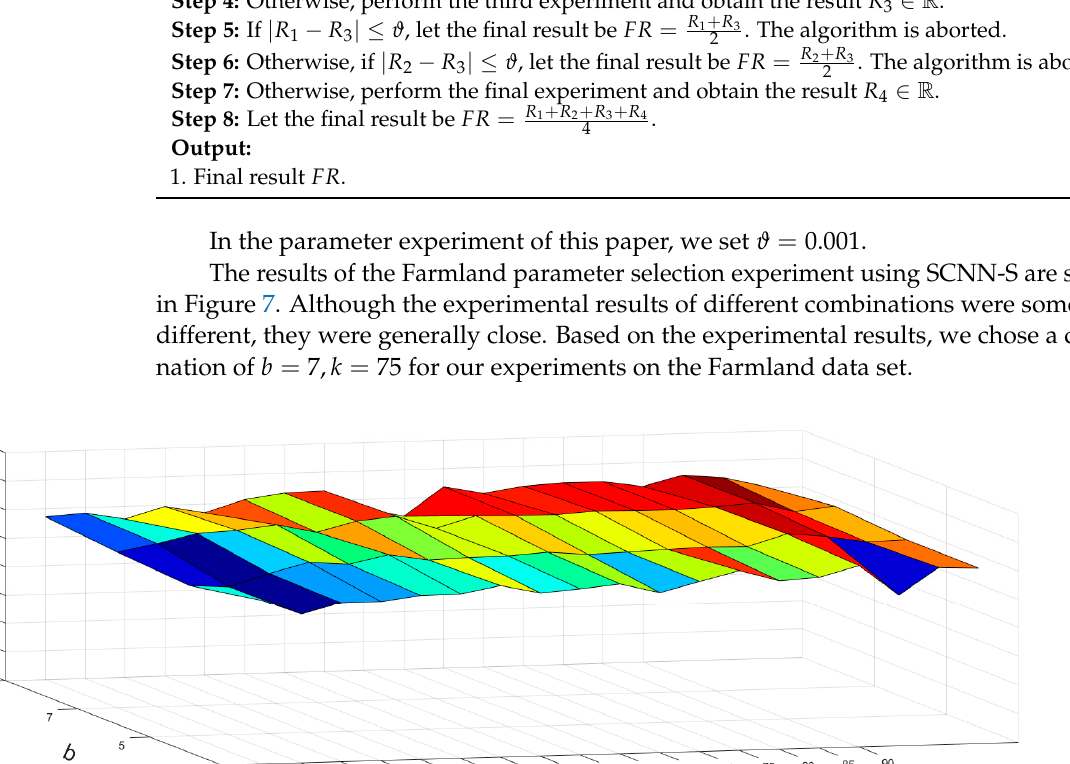
Figure 8. Parameter selection experiment for selecting b and k on the River data set. The results of the USA parameter selection experiment using SCNN-S are shown in Figure 9. Based on the experimental results, we chose a combination of